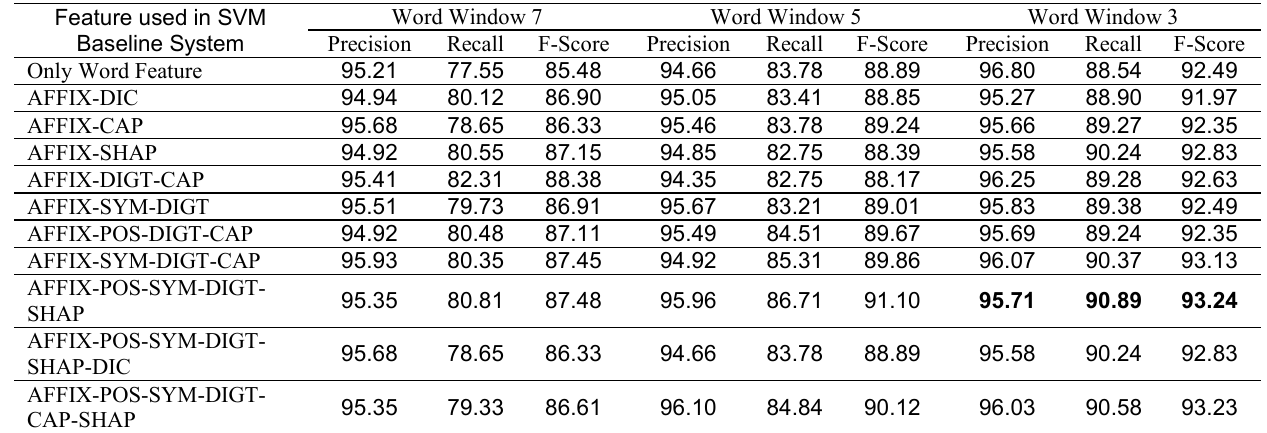
Table 3. Result of Baseline SVM Based NER System on Dataset